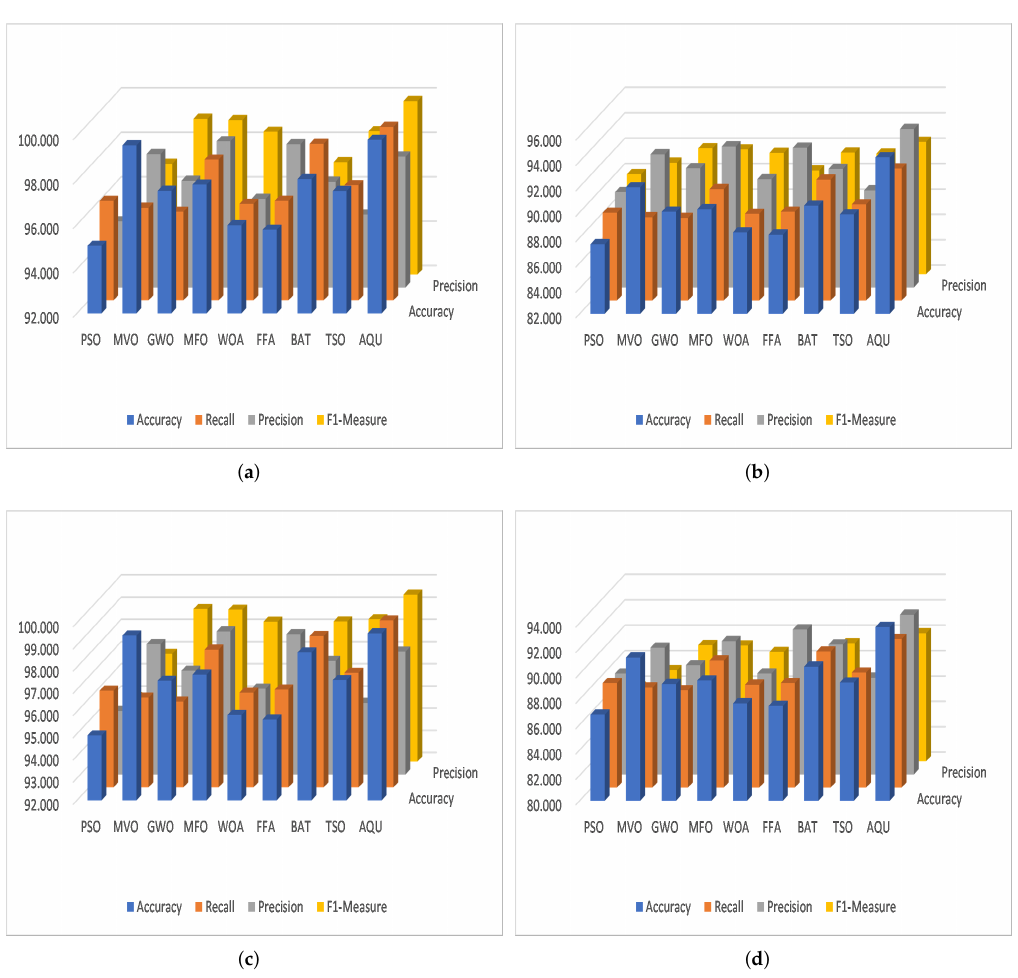
Figure 8. The average among the four datasets for ( a ) Training Binary, ( b ) Testing Binary, ( c ) Training Multi-classification, and ( d ) Testing